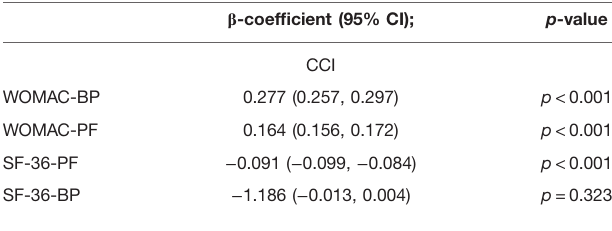
TABLE 5 | Relationship between postoperative CCI and postoperative pain and functional measurements after